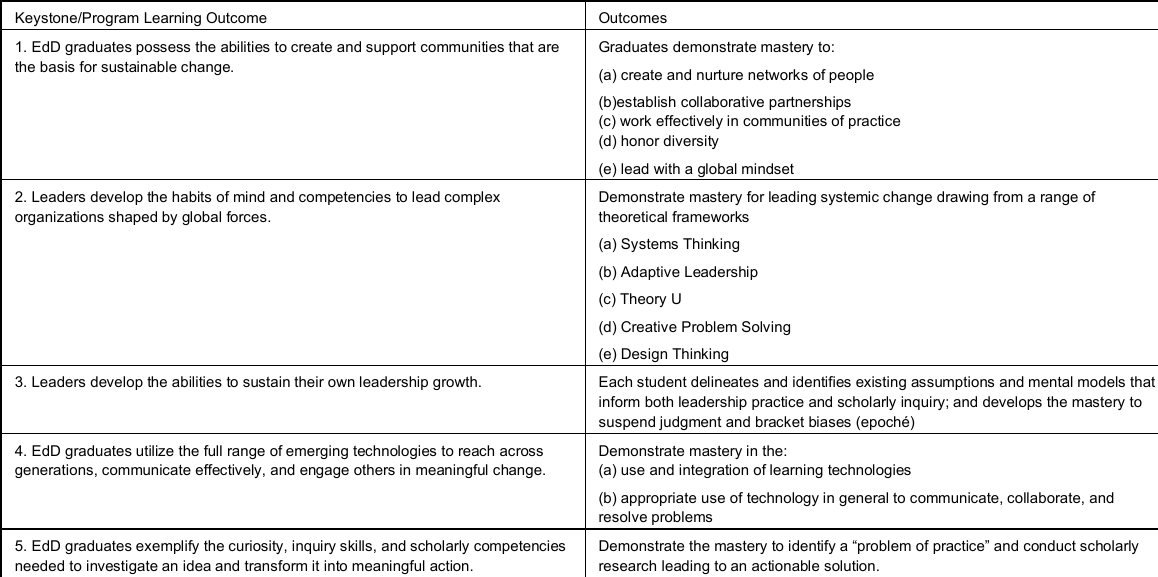
Table 1. School of Education EdD Keystones with Outcomes Keystone/Program Learning